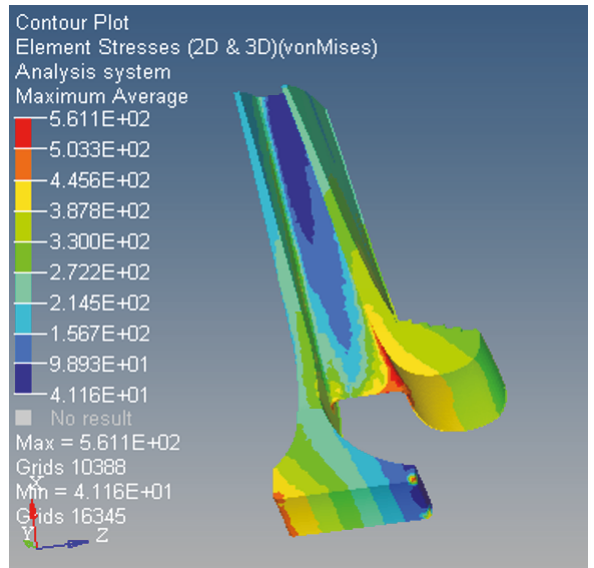
Figure 5: Stress distribution obtained by FEM on the benchmark